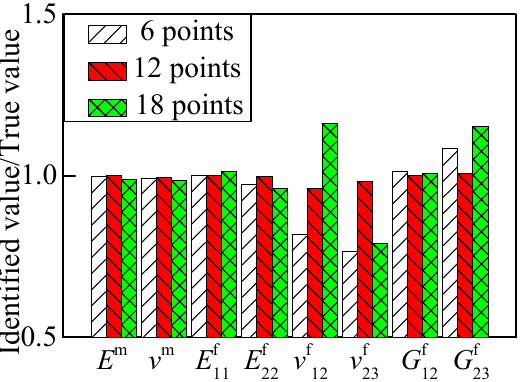
Figure 11. RVE identified result with different numbers of points (three directions). The Poisson’s ratio of fiber and shear modulus in 23 directions had a local conver- gence problem when adding white Gaussian noise to objective variables. We chose one measuring node to observe its sensitivity of static displacements with respect to each pa- rameter, as shown in Figure 12. The Figure 12 shows that the sensitivity for displacements with respect to Poisson’s ratio was much higher than that with respect to modulus, which is one reason for a relative sensitivity matrix. The condition number of the relative sensitivity matrix in different cases is shown in Table 6. The lower the condition number the relative sensitivity matrix had, the more ac- curacy the identified result had. On the other hand, the 2.5D RVE model was asymmetric. Adding white Gaussian noise could influence some identification results in fiber only by x and y direction measuring data.